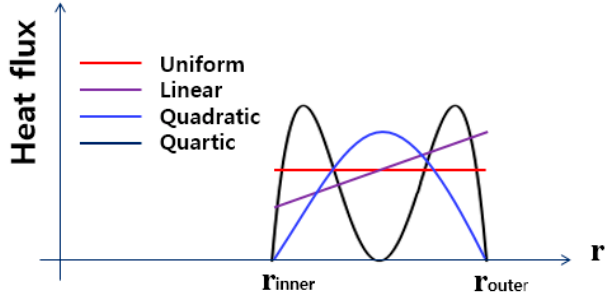
Figure 5. Four types of heat flux input in the radial direction on the brake disc surface.